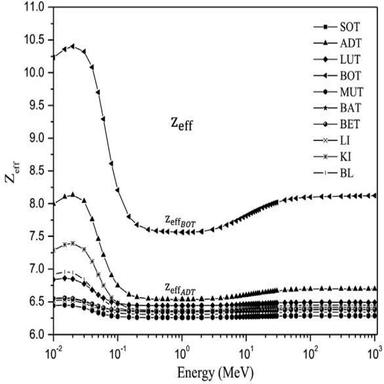
Zeff curves for the different equivalent materials constructed in a range of energy 10 keV to 1 GeV, calculated by Auto-Zeff software.